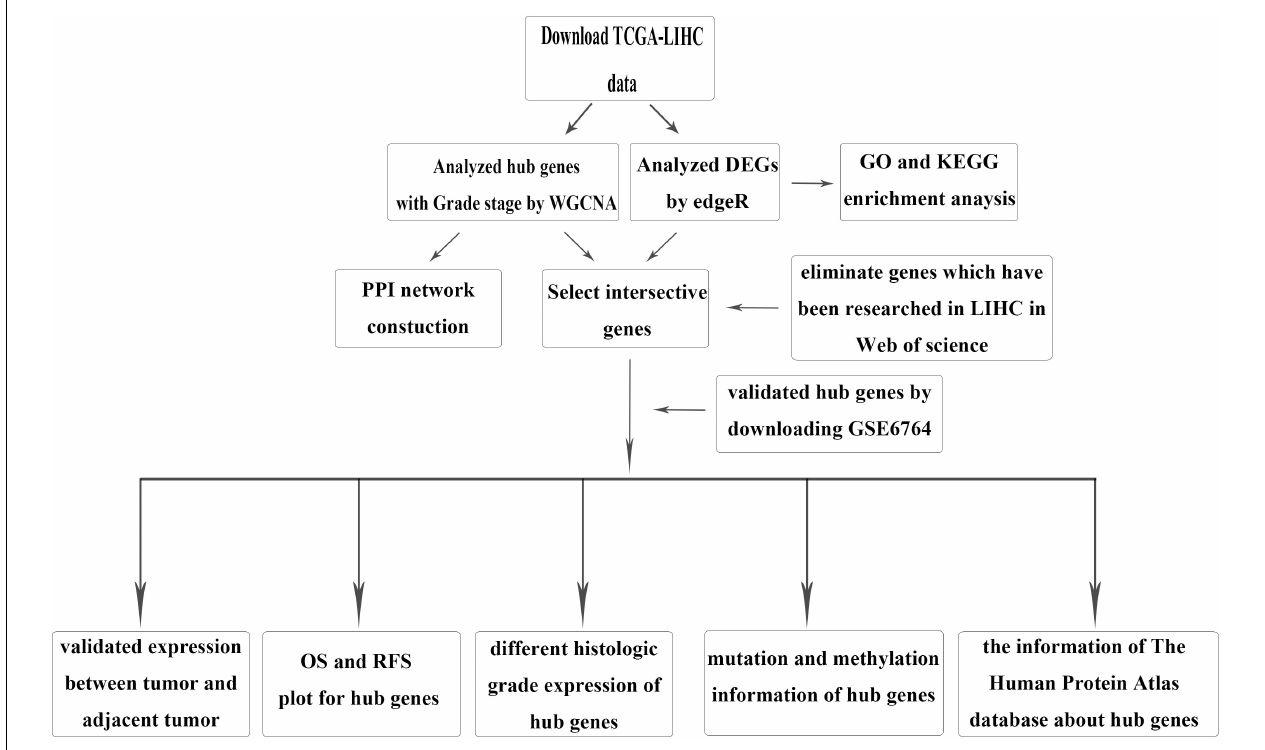
FIGURE 1 | Flow chartpc of data download, processing, analysis, and